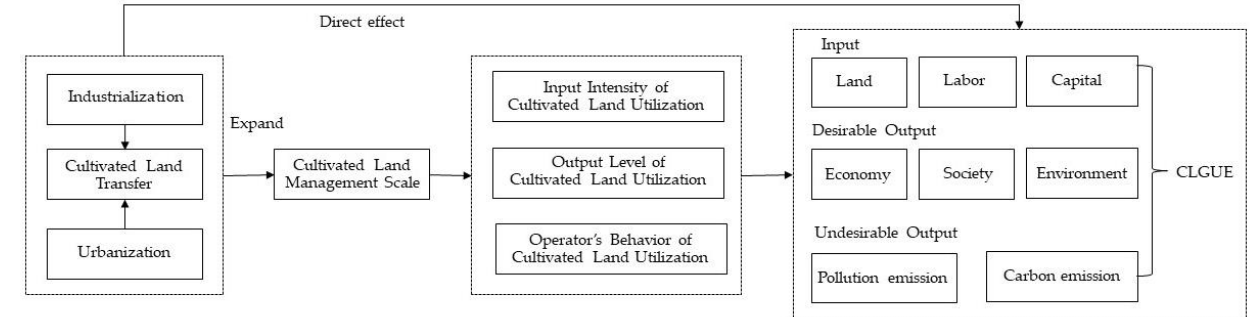
Figure 2. Analysis framework.